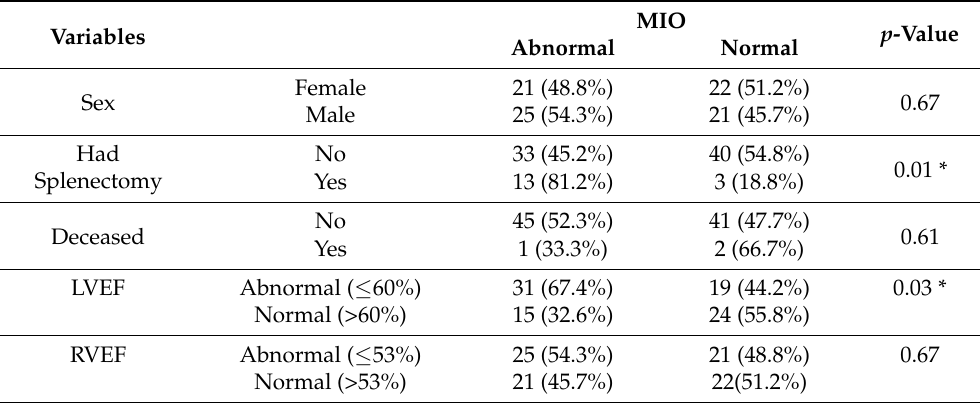
Table 3. Percentages of patients with normal and abnormal MIO in categories based on sex, splenec- tomy, deceased, normal LV and RV ejection